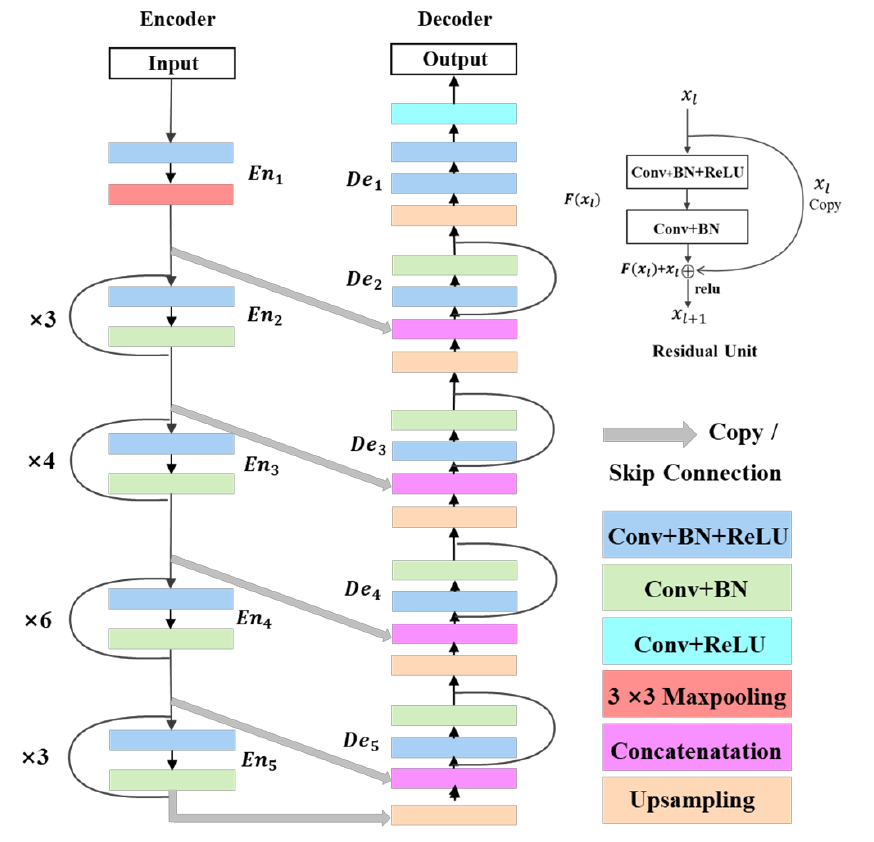
Figure 2. The structure of the proposed D-ResUnet model. Table 1. The parameters and output size of D-ResUnet.